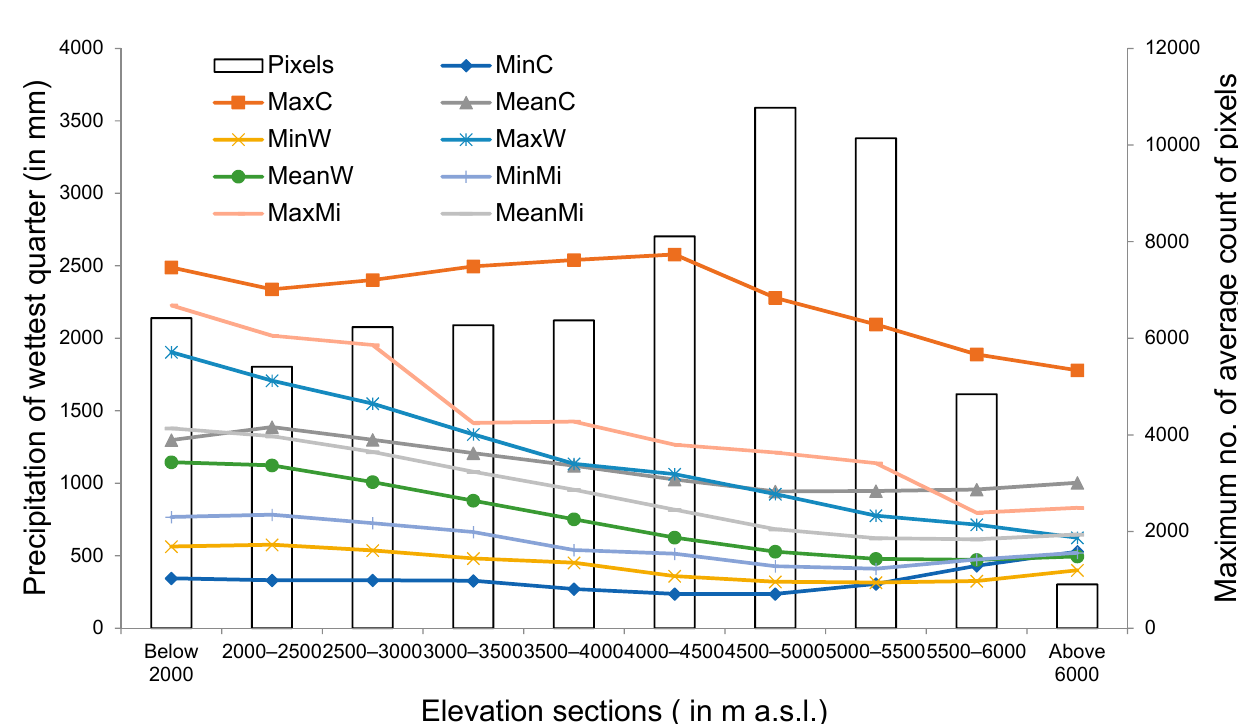
Figure 15. Curves represent minimum, maximum and mean values of precipitation of wettest quarter obtained for each elevation section using WorldClim 2.0, CHELSA and MIROC climate dataset. Here, MinC, MaxC and Mean C represent minimum, maximum and mean values of precipitation of wettest quarter obtained for each elevation section using CHELSA. Similarly, MinW, MaxW and MeanW represent minimum, maximum and mean values of precipitation of wettest quarter obtained for each elevation section using WorldClim 2.0. Correspondingly, MinMi, MaxMi and MeanMi represent minimum, maximum and mean values of precipitation of wettest quarter obtained for each elevation section using MIROC. Bars represent the maximum number of average count of pixels representing snow covered area for each elevation section obtained using MODIS observations.